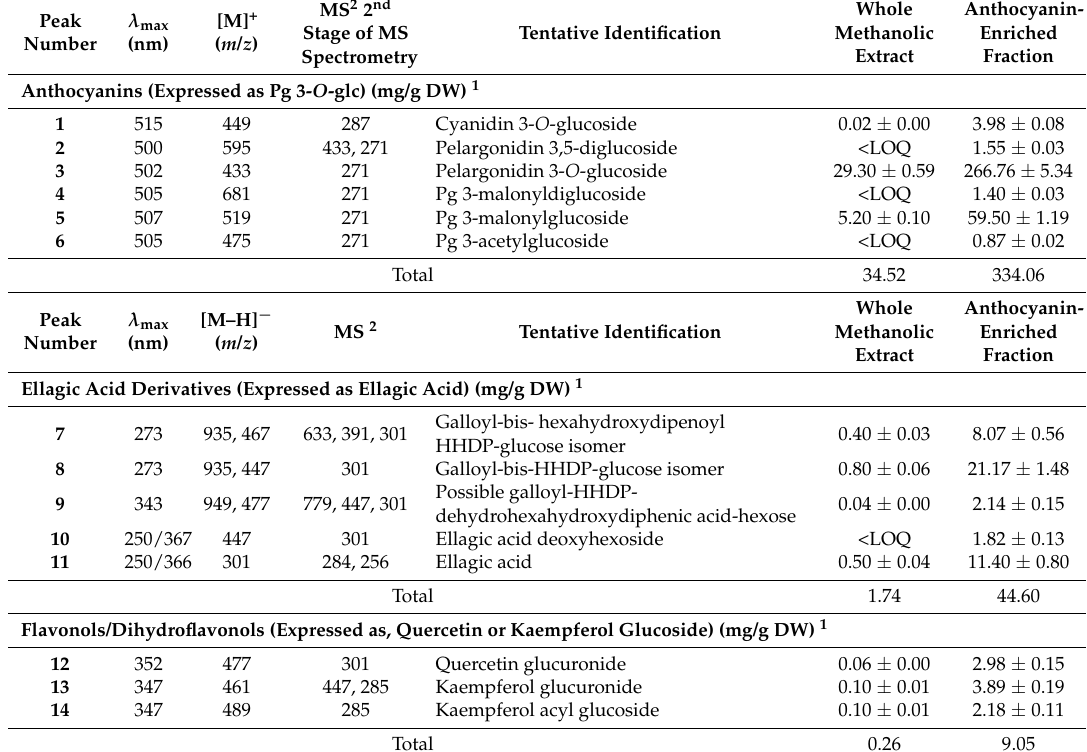
Tentative Identification